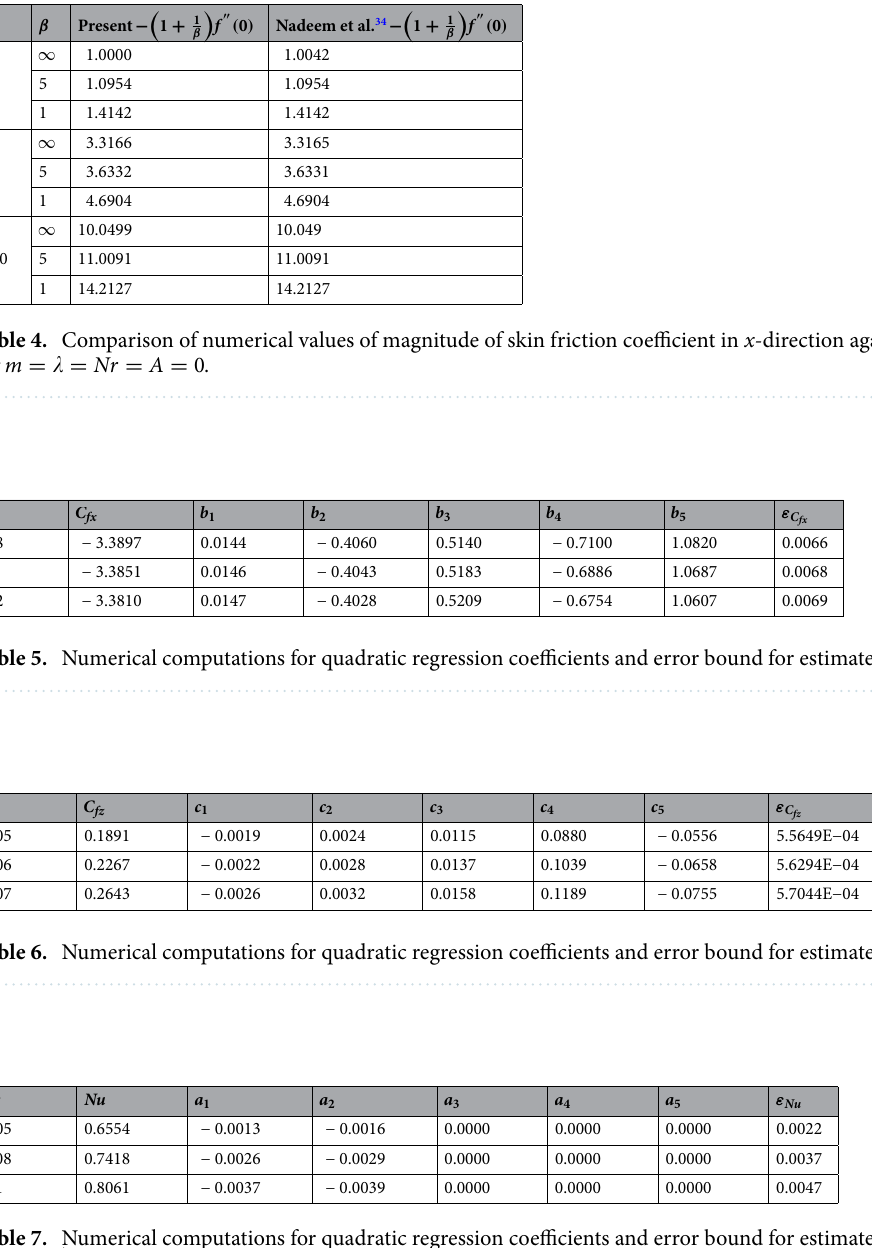
Table 7. Numerical computations for quadratic regression coefficients and error bound for estimated Nu x Re − 1 / 2 x